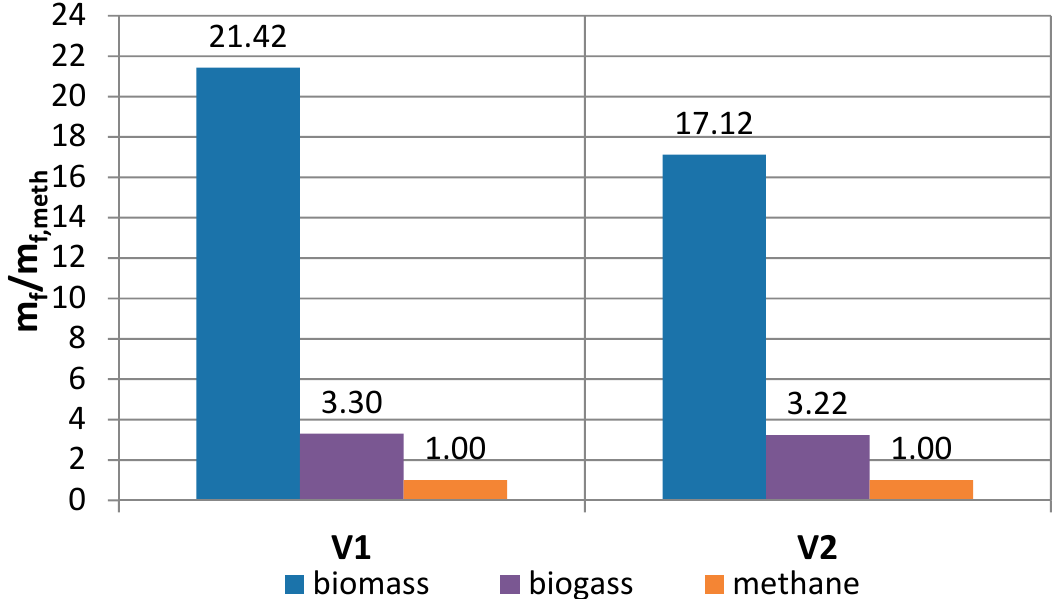
Figure 7. The influence of the structure of the cycle and calorific value of fuel on the relative mass stream of the fuel in the combustion chamber for both variants (referred to methane as a fuel).